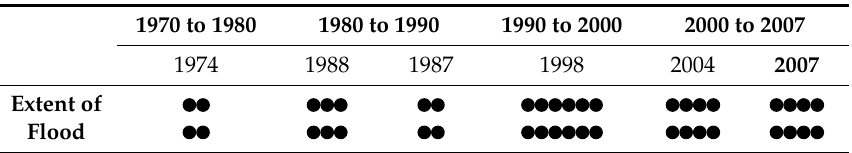
Table 1. Various past floods and their